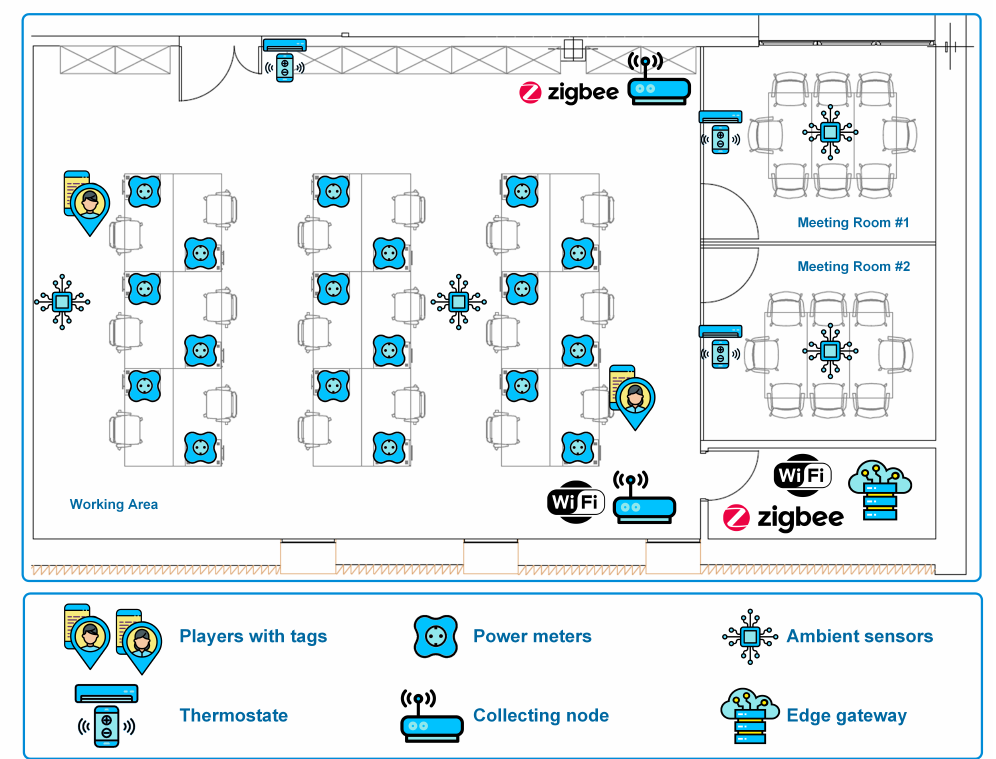
Figure 5. IoT devices and Edge Layer in the evaluation scenario for energy efficiency in public buildings (based on García et al.